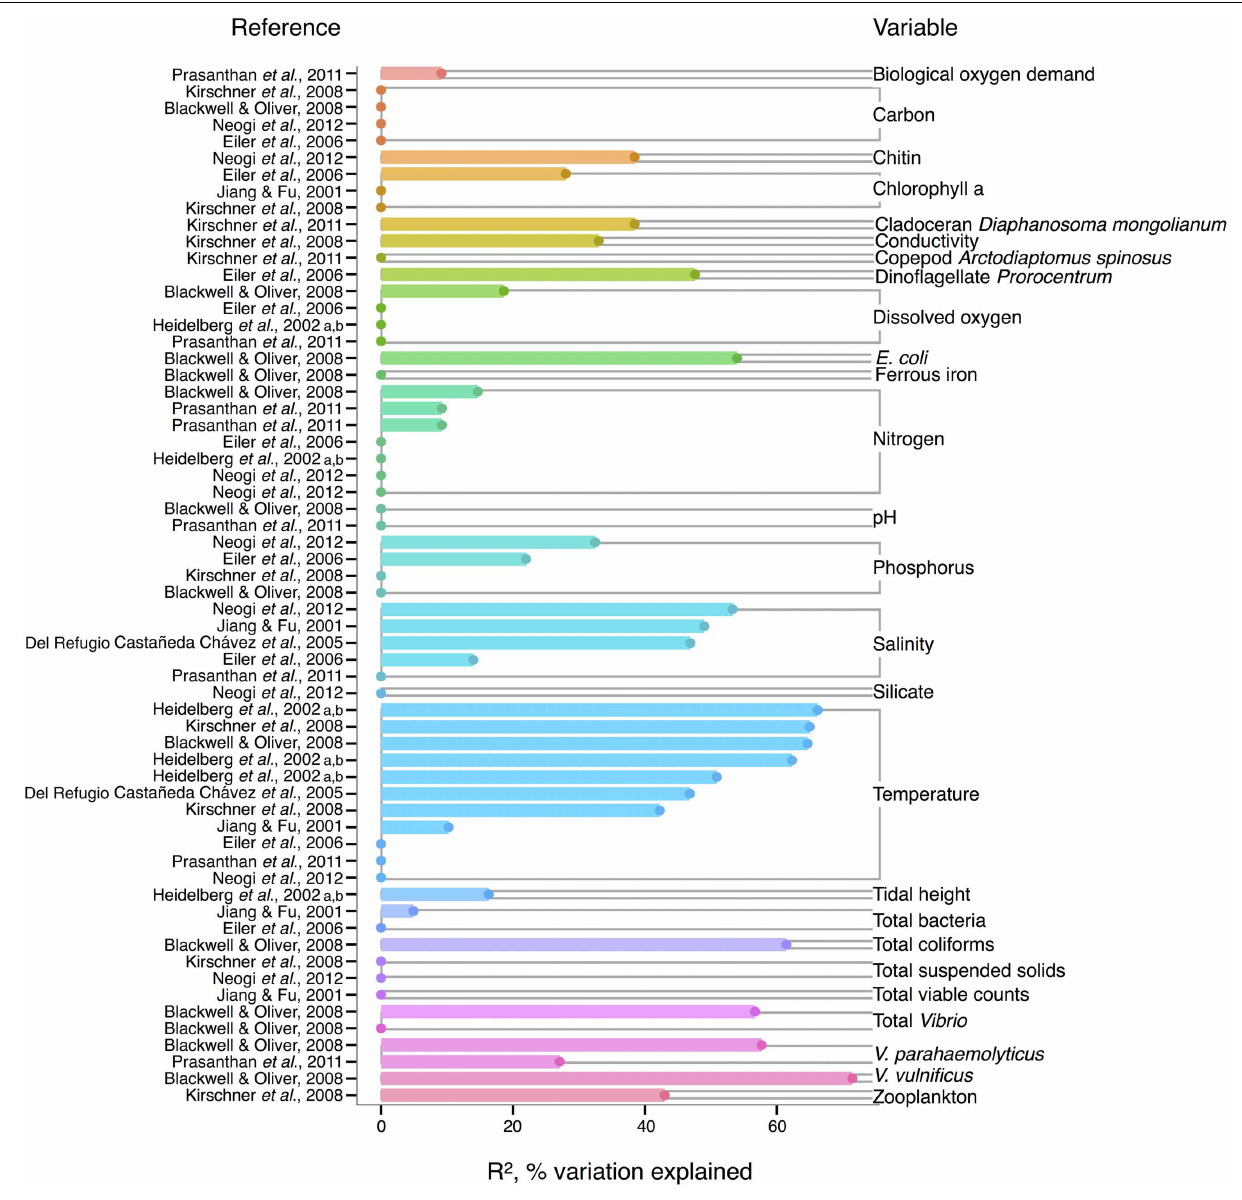
reference may conduct multiple analyses for a given variable (e.g., on subsets of data or considering different variables combinations for data regression). Dots indicate bar heights, and where a dot occurs without a bar, R 2 was non-significant (i.e., R 2 =